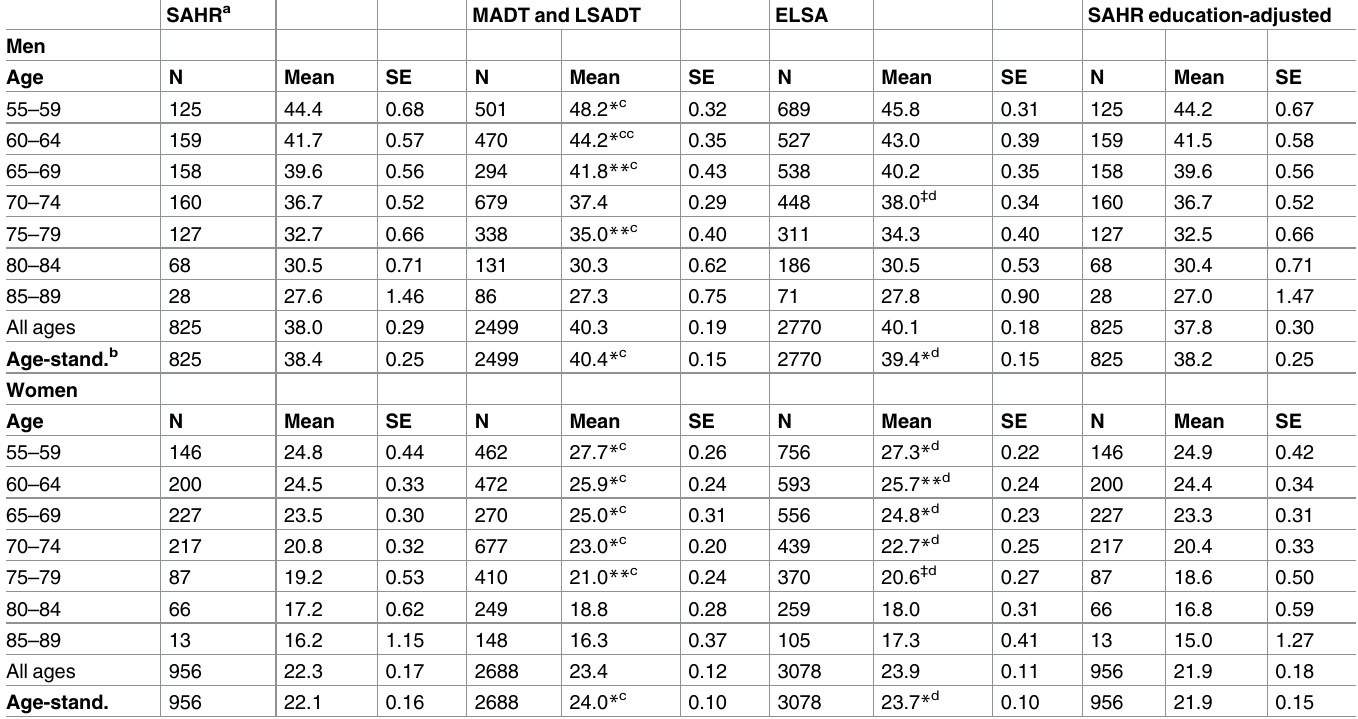
Table 2. Grip strength in Moscow, Denmark,and